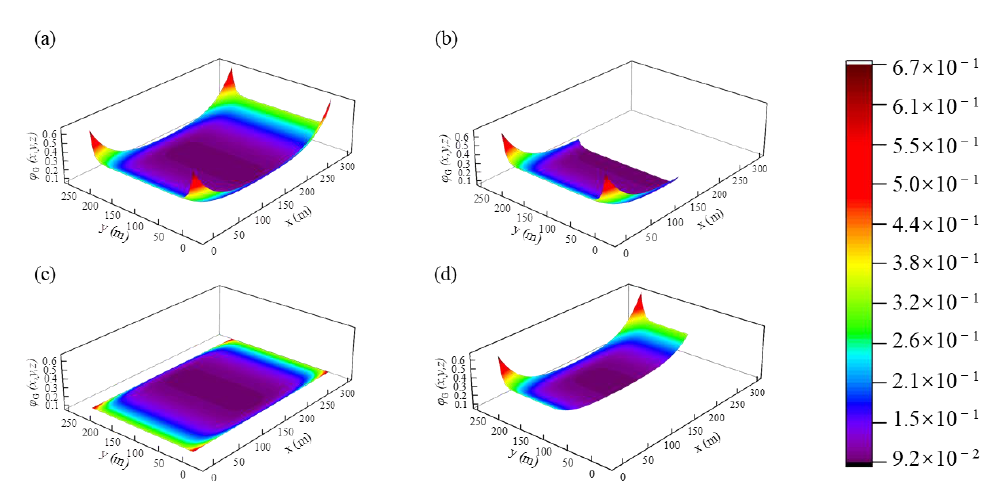
Figure 2. Distribution of porosity in the caving zone of ( a ) global, ( b ) inclination, ( c ) plan, and ( d ) strike.